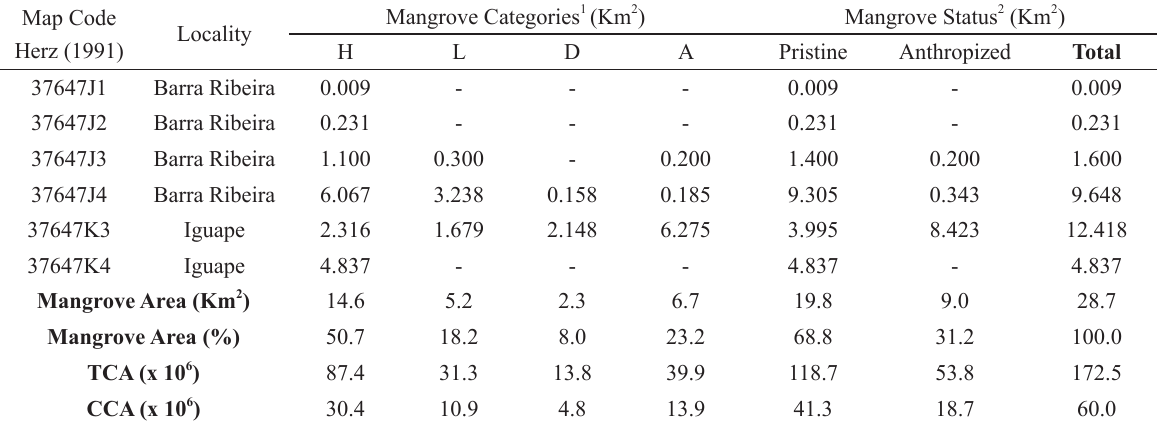
Areas and status of mangrove forests related to the absolute abundance of U. cordatus , using the mean density (6±2 ind.m -2 ) without correction (TCA, total crab abundance), and discounting 65.2% of mortality (CCA, corrected crab abundance). Source of mangrove categories and status from Herz (1991), where: H, high; L, low; D, degraded; and A,